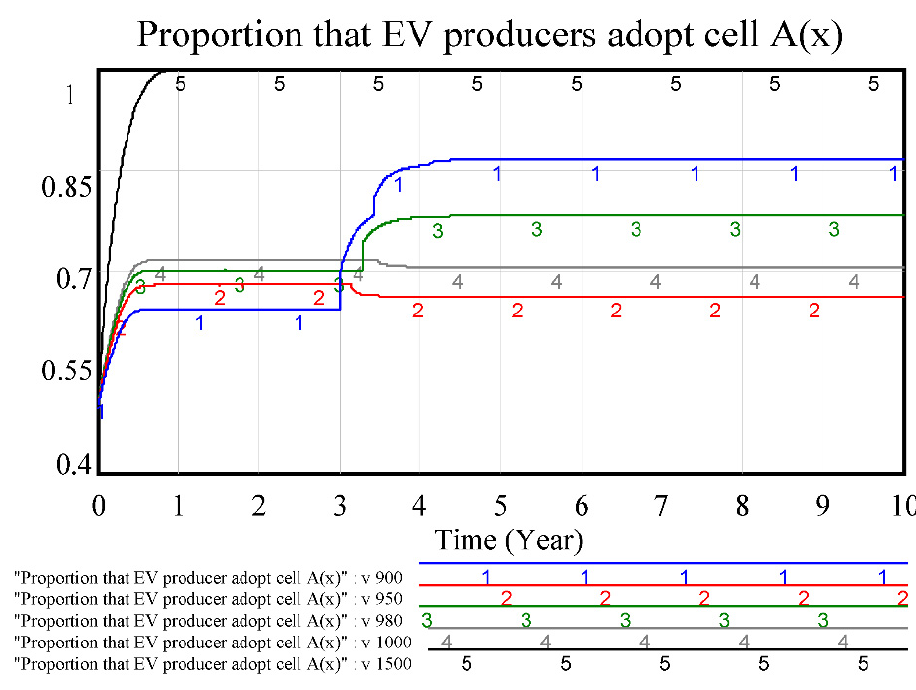
Figure 7. Sensitivity test of factor v that impacts EV producer.